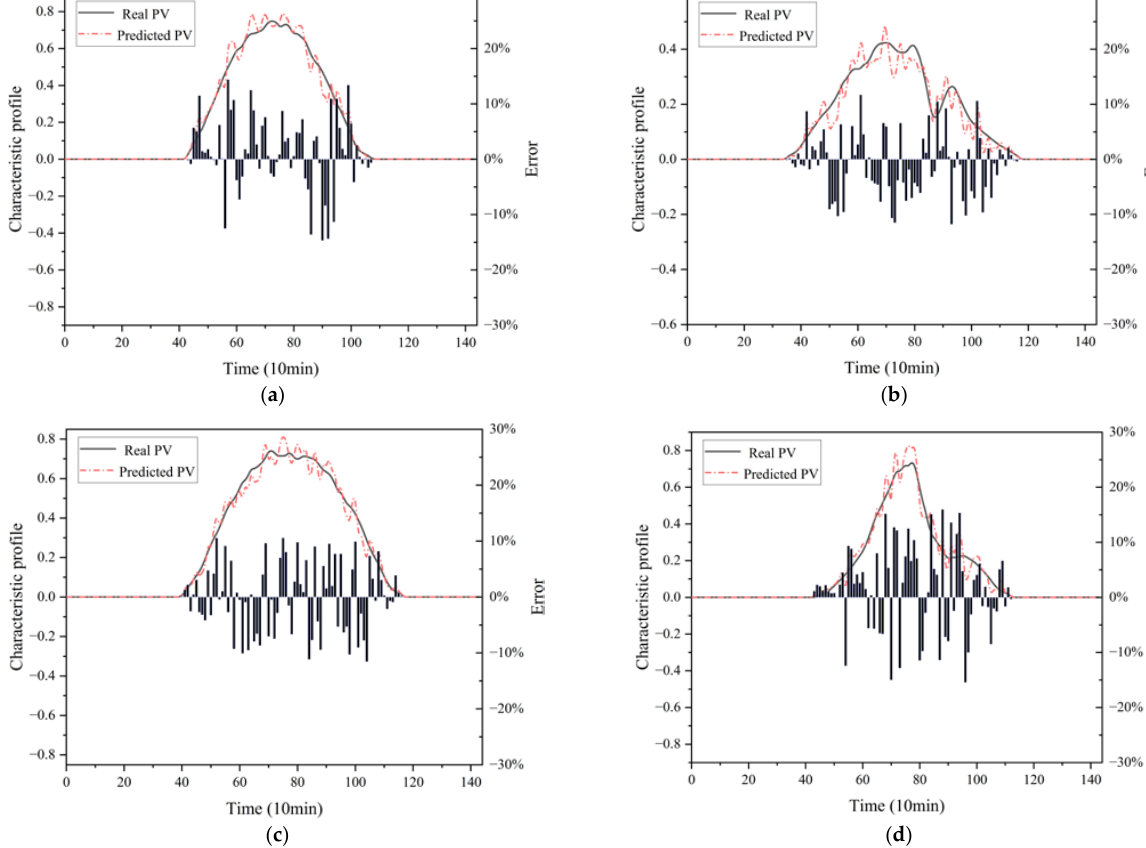
Figure 7. The prediction results and deviations of PV on four typical days. ( a ) Spring; ( b ) Summer; ( c ) Autumn; ( d ) Winter.